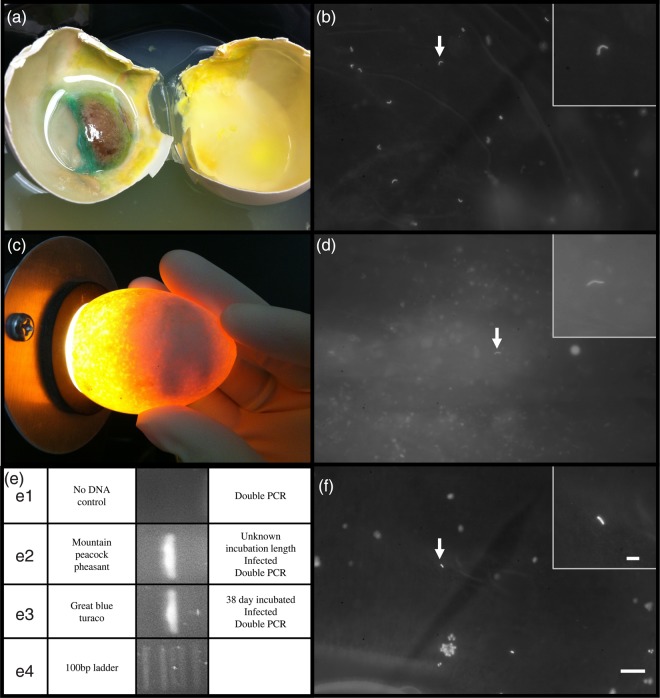
Detection of perivitelline membrane-bound sperm by Hoechst 33342 staining in artificially infected chicken egg (a and b) and naturally infected mountain peacock-pheasant egg (c, d and e2) and great blue turaco egg (e3 and f). Insets represents increased magnification. (e) Polymerase chain reaction amplification of presumed sperm DNA from microbially infected vitelline membranes. Bar represents 50 or 10 μm (insets). Great blue turaco egg, incubation data unknown, ambient temperature for up to 38 days.